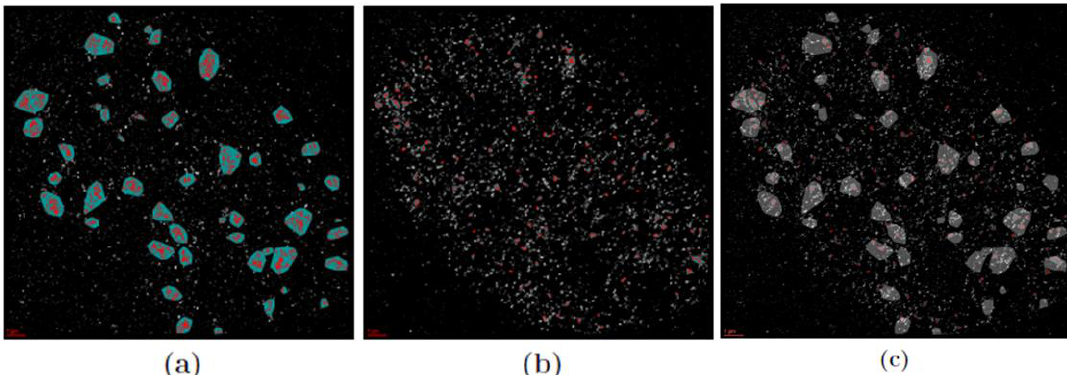
Figure 3. Examples of cluster images of a human skin fibroblast nucleus 60 min after irradiation with 2 Gy. ( a ) γ H2AX labeling can be found in clusters highlighted by red points in closed areas. ( b ) MRE11 labeling is dispersed over the cell nucleus and clustered, too. ( c ) The merged image of ( a ) and ( b ) indicating the embedding of MRE11 in γ H2AX clusters. Scale bar: 2 µm.